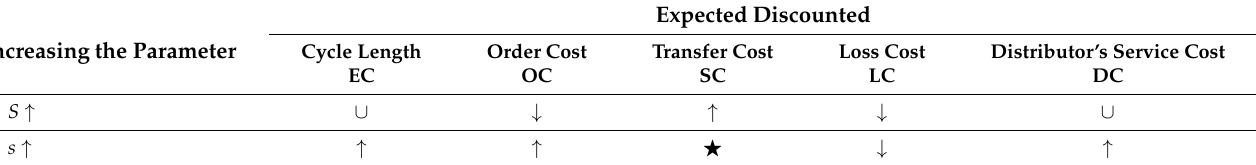
Table 1. The impact of the parameters on the system’s